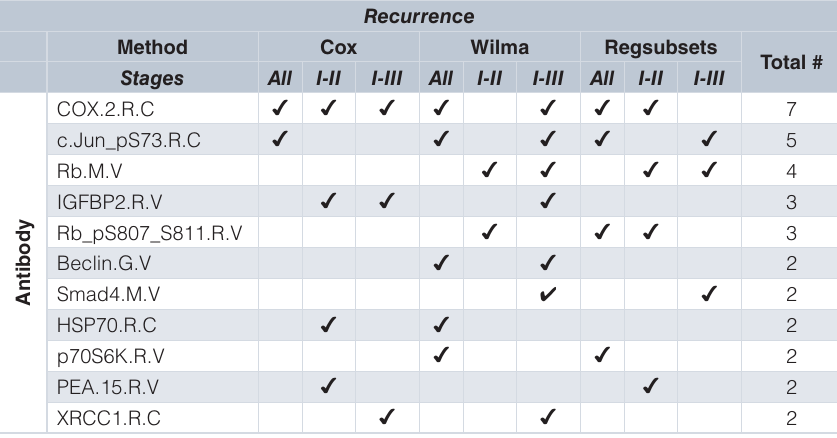
Table 4. Summary tables for recurrence, ordered by the number of times each protein was selected. Proteins that were identified by more than one computational method (Cox regression, Wilma, or Regsubsets) were included. Proteins identified by Cox regression and the Wilma algorithm were significantly associated with prognosis (p<0.05); proteins are included for Regsubsets if they were identified five times or